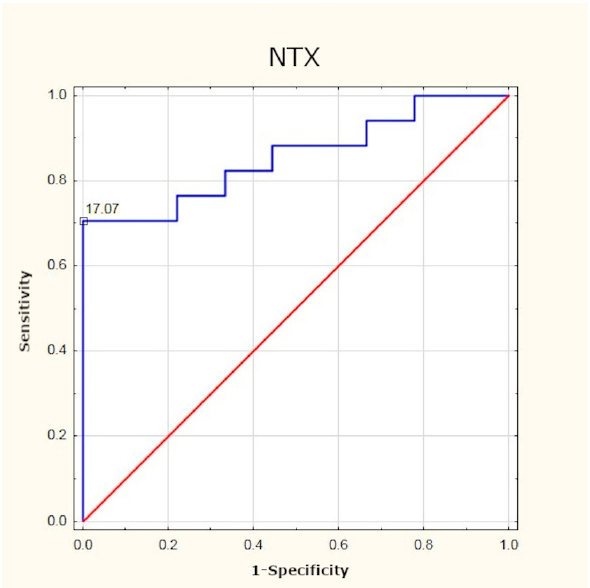
Figure 7. Determination of optimum cut-off point for NTX using ROC curve.